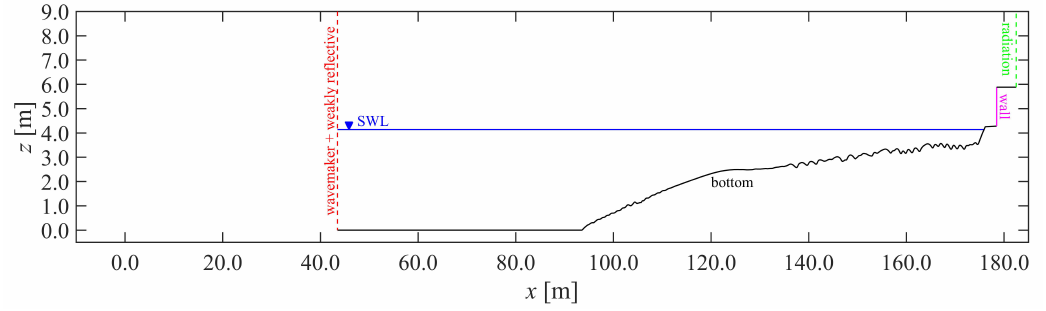
Figure 3. Definition of the SWASH computational domain, with coloured indication of the model boundaries. The wavemaker and weakly reflective boundary is positioned at the most o ff shore wave gauge WG02 location (x = 43.5 m). The SWL is indicated in blue (z = 4.14 m). Note: The axes are in a distorted